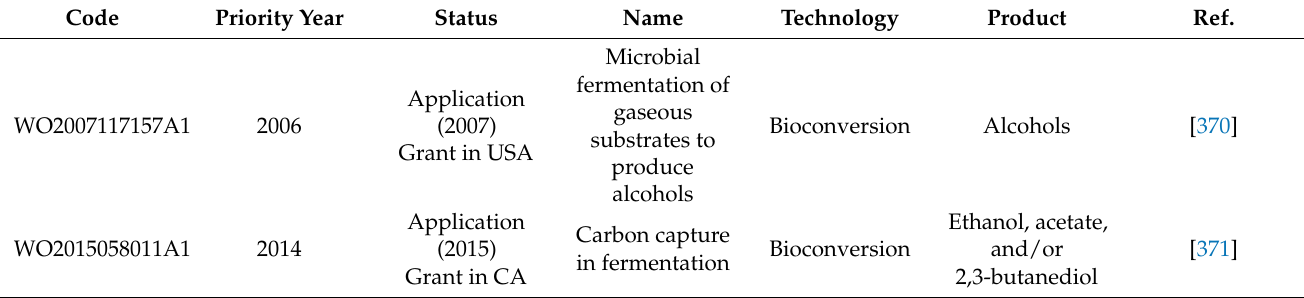
Table 13. Patents related to bioconversion and deposited by LanzaTech.